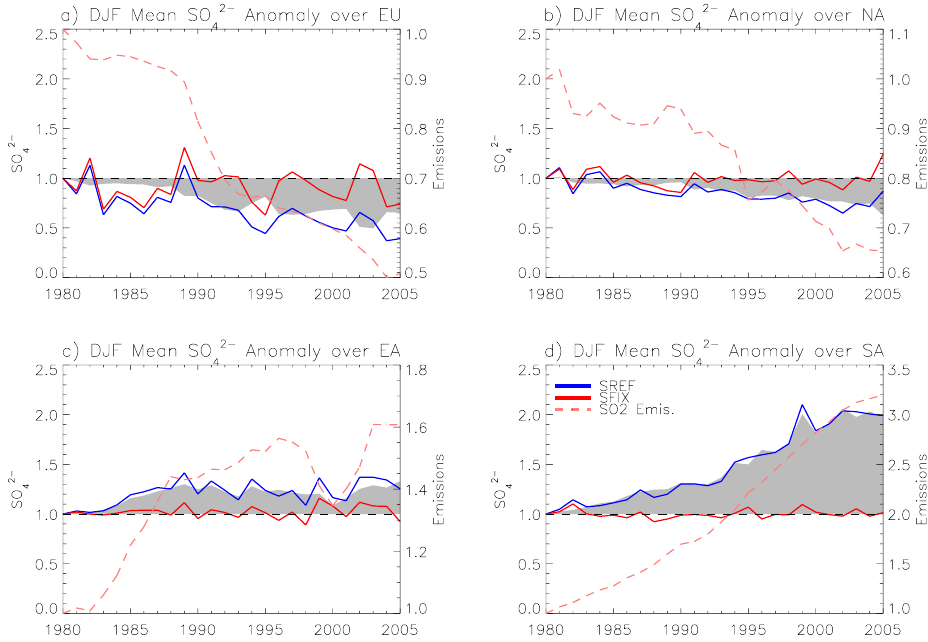
Fig. 11. Winter (DJF) anomalies of surface SO 2 − concentrations averaged over the selected regions (shown in Fig. 1). On the left y-axis 4 anomalies of SO 2 − surface concentrations for the period 1980–2005 are expressed as the ratios between seasonal means for each year and 4 the year 1980. The blue line represents the SREF simulation (changing meteorology and changing anthropogenic emissions), the red line the SFIX simulation (changing meteorology and fixed anthropogenic emissions at the level of 1980), while the gray area indicates the SREF- SFIX difference. On the right y-axis the pink dashed line represents the changes, i.e. the ratio between each year and 1980, of total annual sulfur emissions.